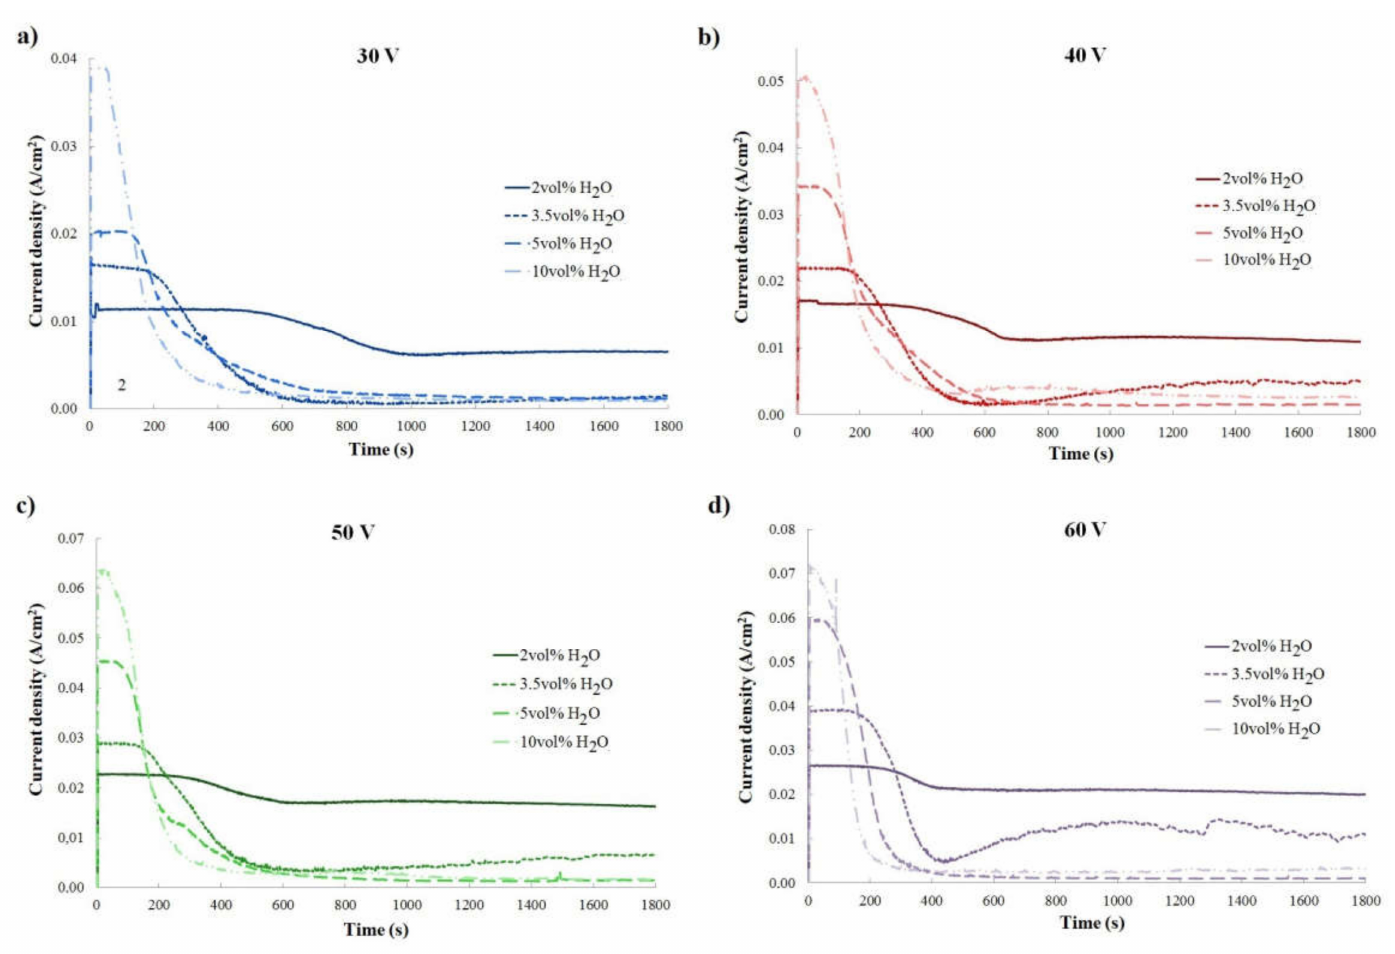
Figure 2. Current curves presented depending on content of water in ethanol-based electrolyte with constant anodization voltage: ( a ) 30 V; ( b ) 40 V; ( c ) 50 V; and ( d ) 60